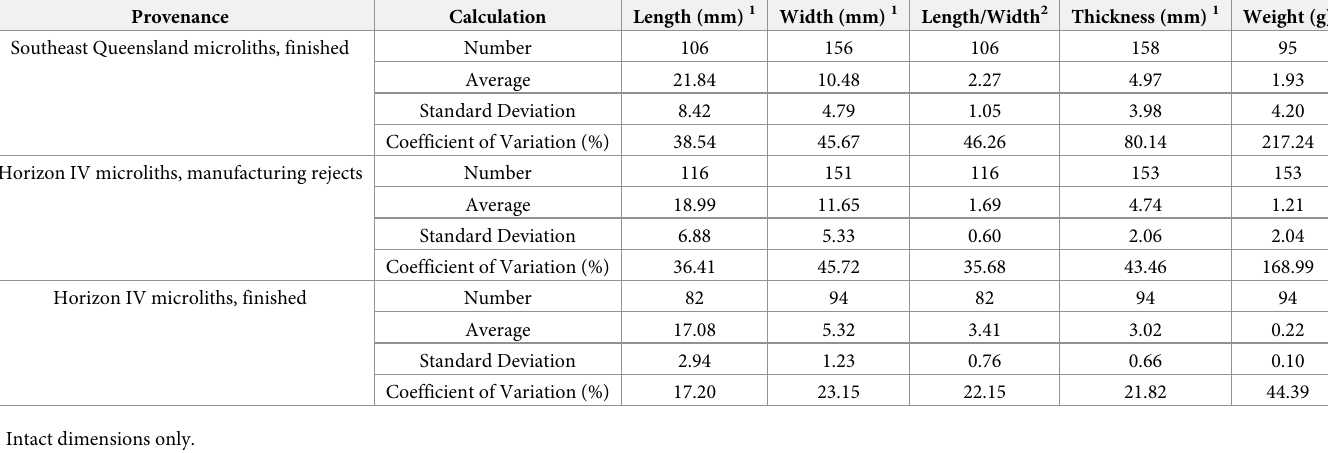
Table 11. Dimensions of backed microliths from southeast Queensland, Australia, and Horizon IV, Saruq al-Hadid.